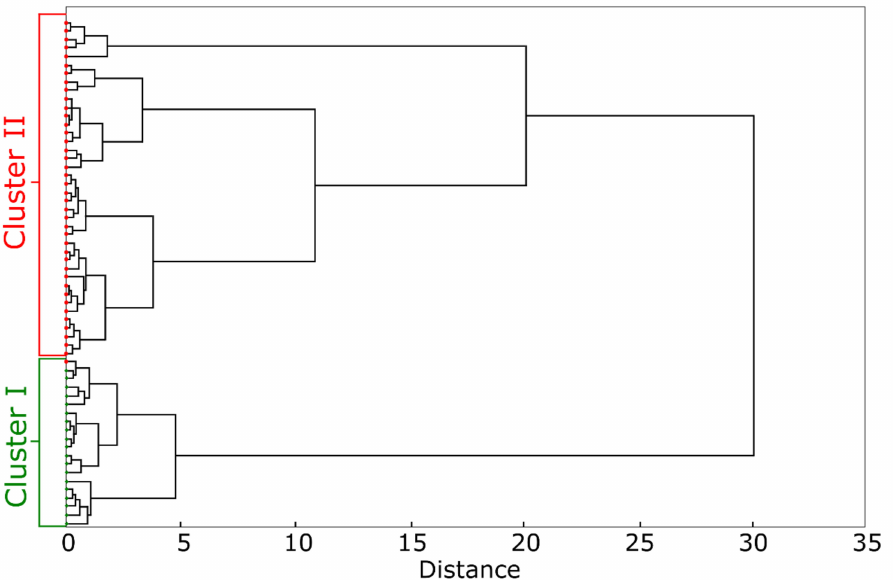
Figure 3. The cluster analysis based on the first derivative of IR spectra of guinea pig sera. Upper branches on the dendrogram (Cluster II)— H. pylori infected animals. Lower branches on the dendro- gram (Cluster I)—noninfected animals. The dendrogram was calculated using Ward‘s method and Manhattan